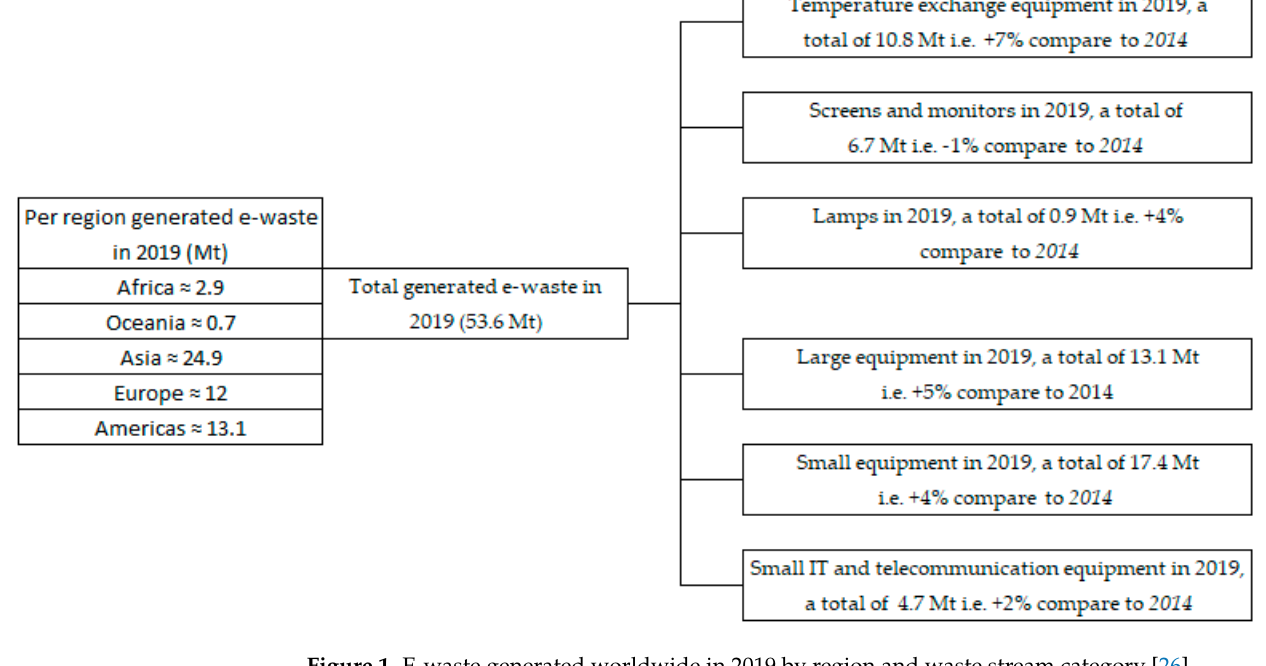
Figure 1. E-waste generated worldwide in 2019 by region and waste stream category [26]. Table 1. Average weight and estimated lifespan of devices mentioned above